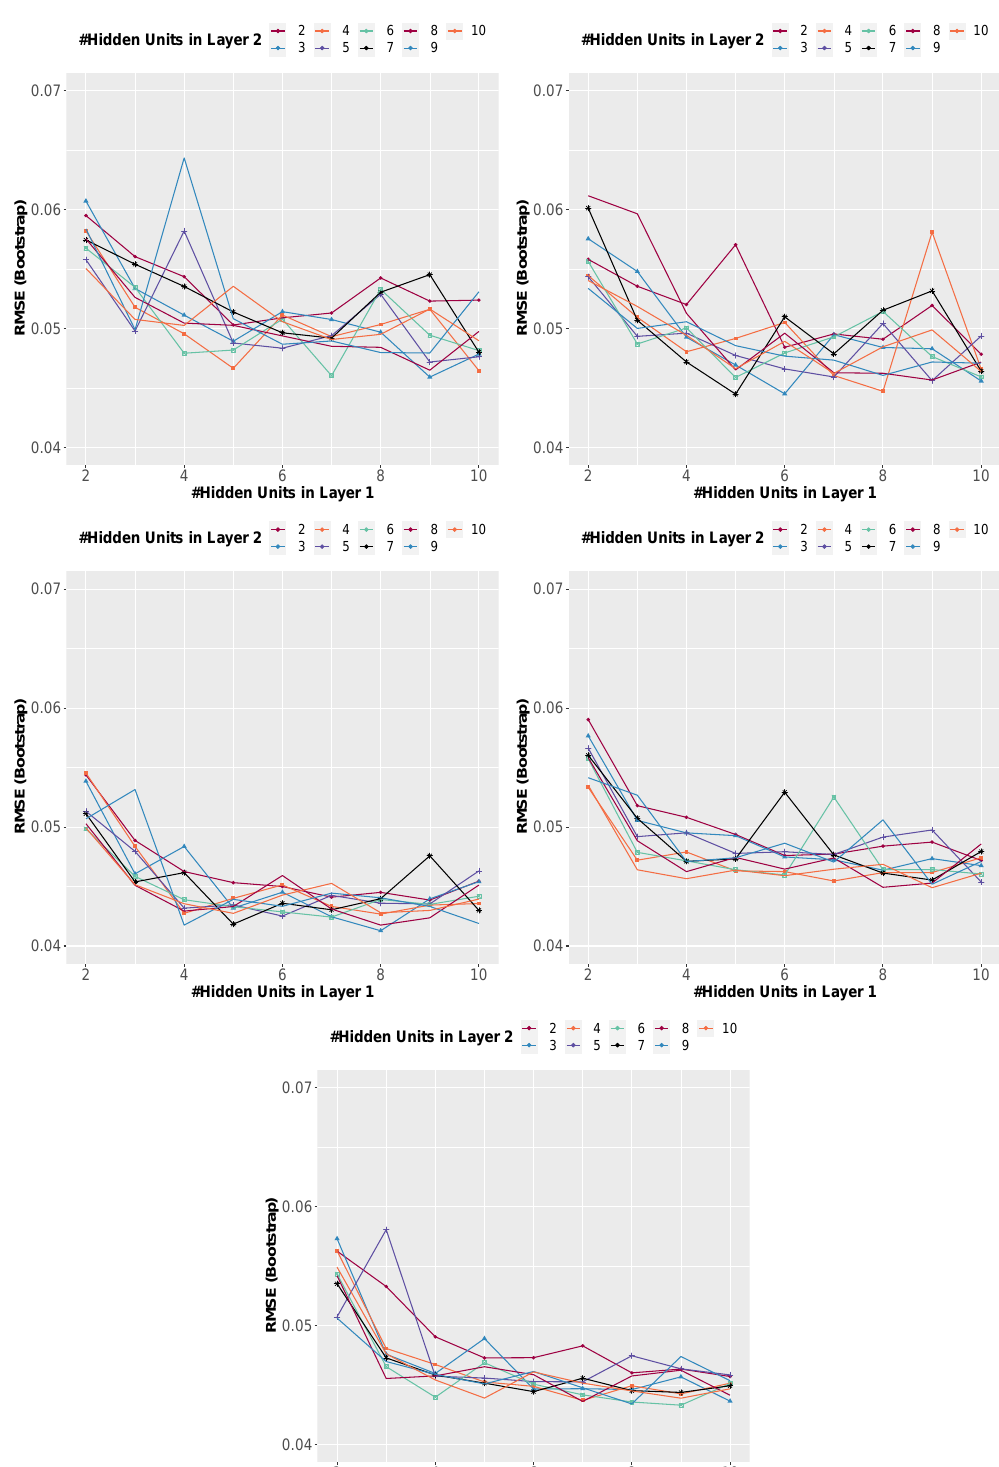
Figure 3. ANN test for choosing the ideal number of hidden neurons varying the input data. From top to bottom and left to right the number of input data goes from 7 to 3. The x axis represents the number of neurons in the first hidden layer and the y axis is the RMSE value. Each color is a different number of neurons in the second hidden